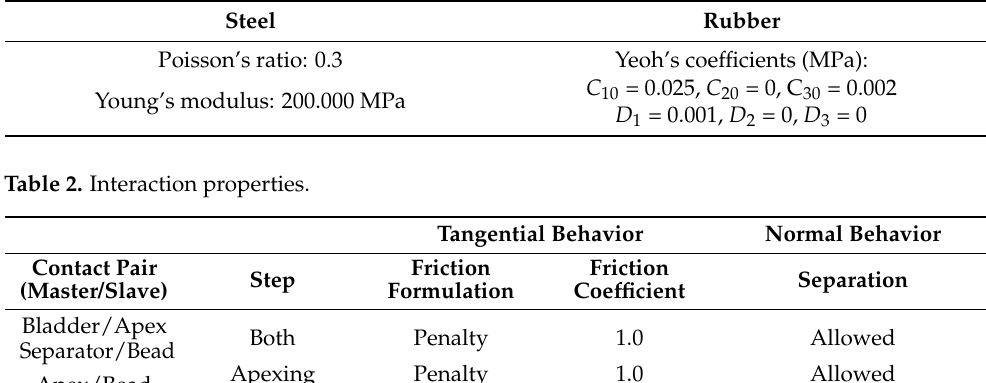
Table 1. Material data.